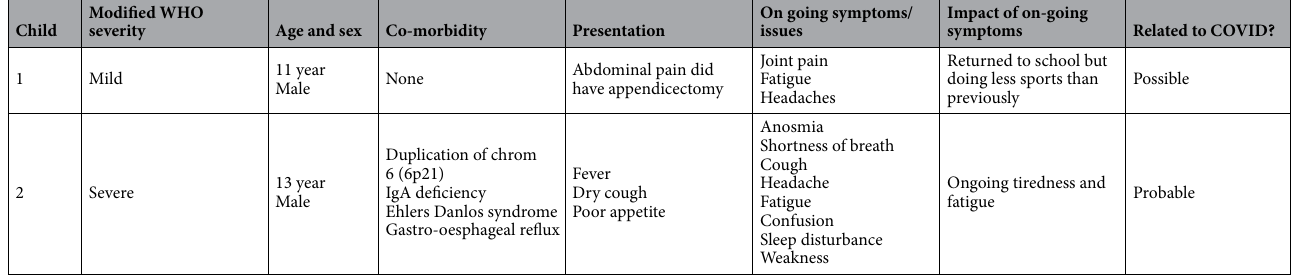
Table 2. Children and young people with ongoing